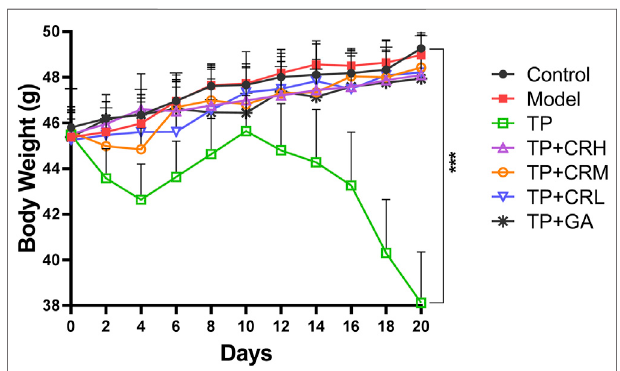
FIGURE 2 | Body weight changes during 20 days of treatment. (n = 8) *** p < 0.001 vs